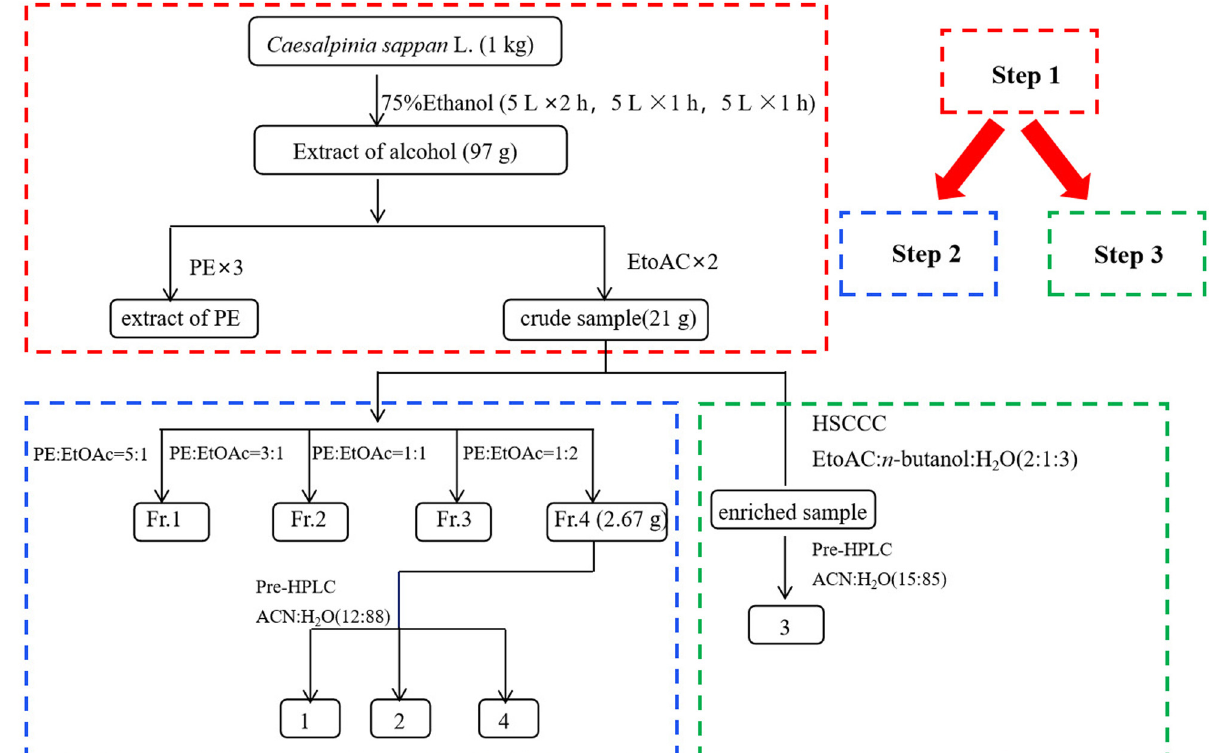
Figure 1: Flow chart of the separation of C. sappan